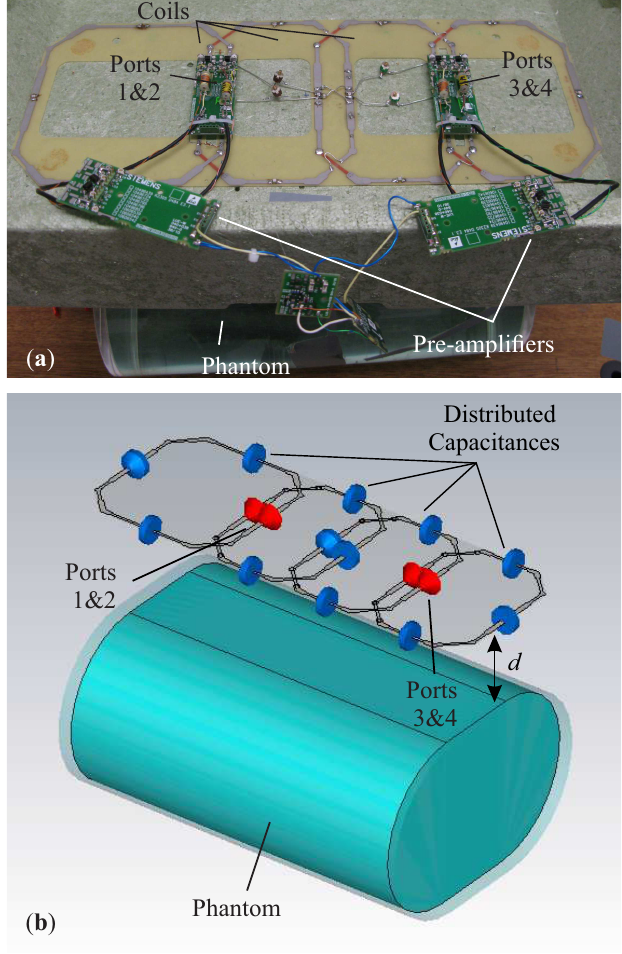
Figure 7. Four-channel coil array: ( a ) photograph; ( b ) model of electromagnetic field simulation. Four planar coil elements on a fiberglass reinforced epoxy laminate (FR-4) substrate are inductively decoupled. Distributed capacitors are used in each element for frequency tuning. The array is placed at d = 13cm above a saline water